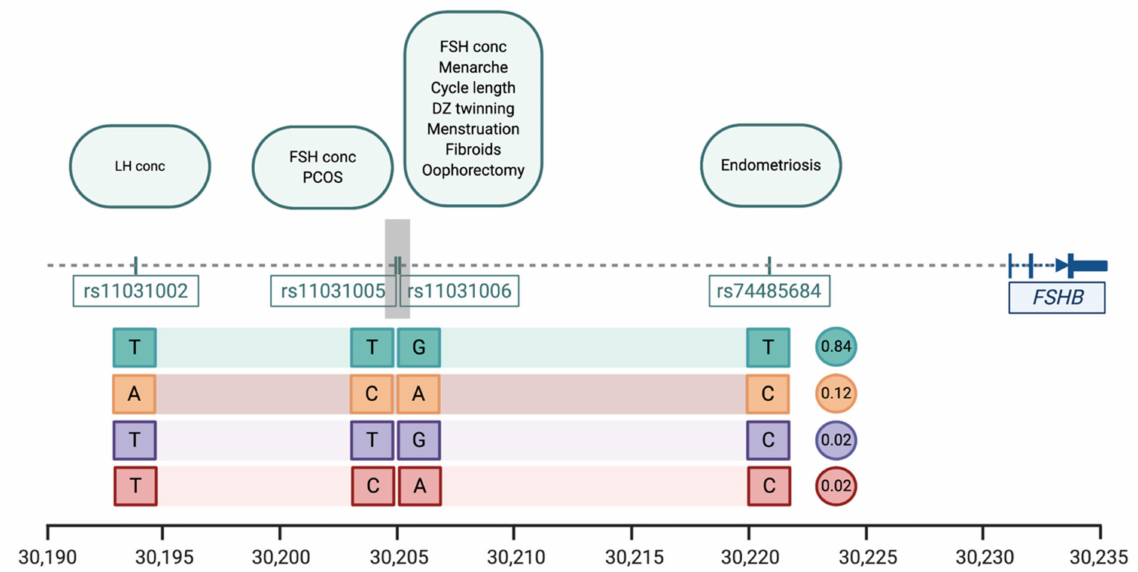
Figure 2. The location of SNPs significantly associated with reproductive traits and diseases from GWAS studies in the region immediately upstream of the FSHB locus on chromosome 11. The scale at the bottom of the figure is given in kilobases (kb) based on coordinates for human chromosome 11 build hg38. Lead SNPs identified in individual studies are shown below the dotted line and the individual traits and diseases associated with those lead SNPs are listed in the boxes above the line (see Table 3). The four SNPs are all highly correlated and haplotype analysis showing the association of alleles for individual SNPs identified four common allelic combinations or haplotypes with the expected frequencies of each haplotype shown in the circles to the right of each